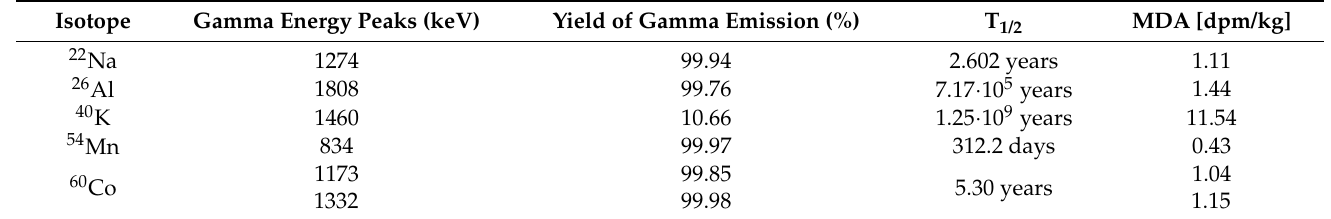
Table 2. Analyzed isotopes along with their gamma energy lines, half-lives (NDS base (IAEA Nuclear Data Services)) and an example of MDA results.